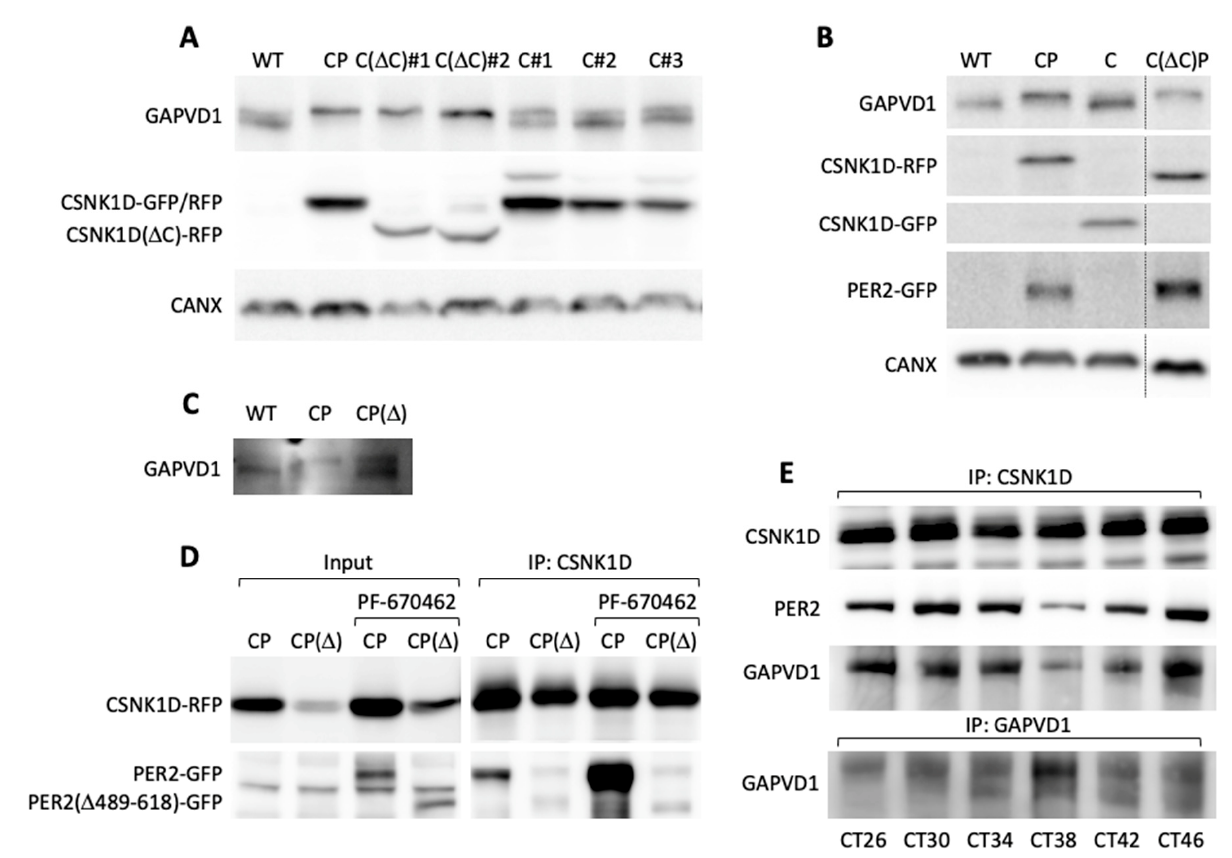
Figure 5. Phosphorylation of GAPVD1 is inhibited by the C-terminal tail of CSNK1D and requires direct interaction of CSNK1D and PER2. ( A ) Western blot analysis of GAPVD1 in HT1080 wild type cells, CP cells, and different clonal cell lines expressing CSNK1D( Δ 317-342)-RFP (C( Δ C)#1-2) or CSNK1D-RFP (C#1–3); ( B ) HT1080 wild type cells and cells overexpressing CSNK1D-RFP or CSNK1D( Δ 317–342)-RFP together with PER2-GFP (CP and C( Δ C)P), and cells overexpressing CSNK1D-GFP alone ( C ) were analyzed with antibodies against GAPVD1, CSNK1D, and PER2; an antibody against Calnexin (CANX) was used as a control for equal loading; dashed lines indicate lane splicing within one and the same Western blot membrane; ( C ) Western blot analysis of GAPVD1 in HT1080 wild type cells and cells expressing CSNK1D-RFP together with PER2-GFP (CP) or PER2( Δ 489–618)-GFP (CP( Δ )); ( D ) CSNK1D was immunoprecipitated from CP or CP( Δ ) cells with or without pre-treatment with PF-670462 for 18 h. Cell lysates (Input) and immunoprecipitated proteins were analyzed with antibodies against CSNK1D and PER2; ( E ) CSNK1D or GAPVD1 were immunoprecipitated from synchronized U2OS cells at the indicated circadian times (CT) after dexamethasone treatment, and immunoprecipitated proteins were analyzed with antibodies against CSNK1D, PER2, and GAPVD1. Similar levels of the non-rhythmic CSNK1D protein indicate equal IP efficiencies in all samples.